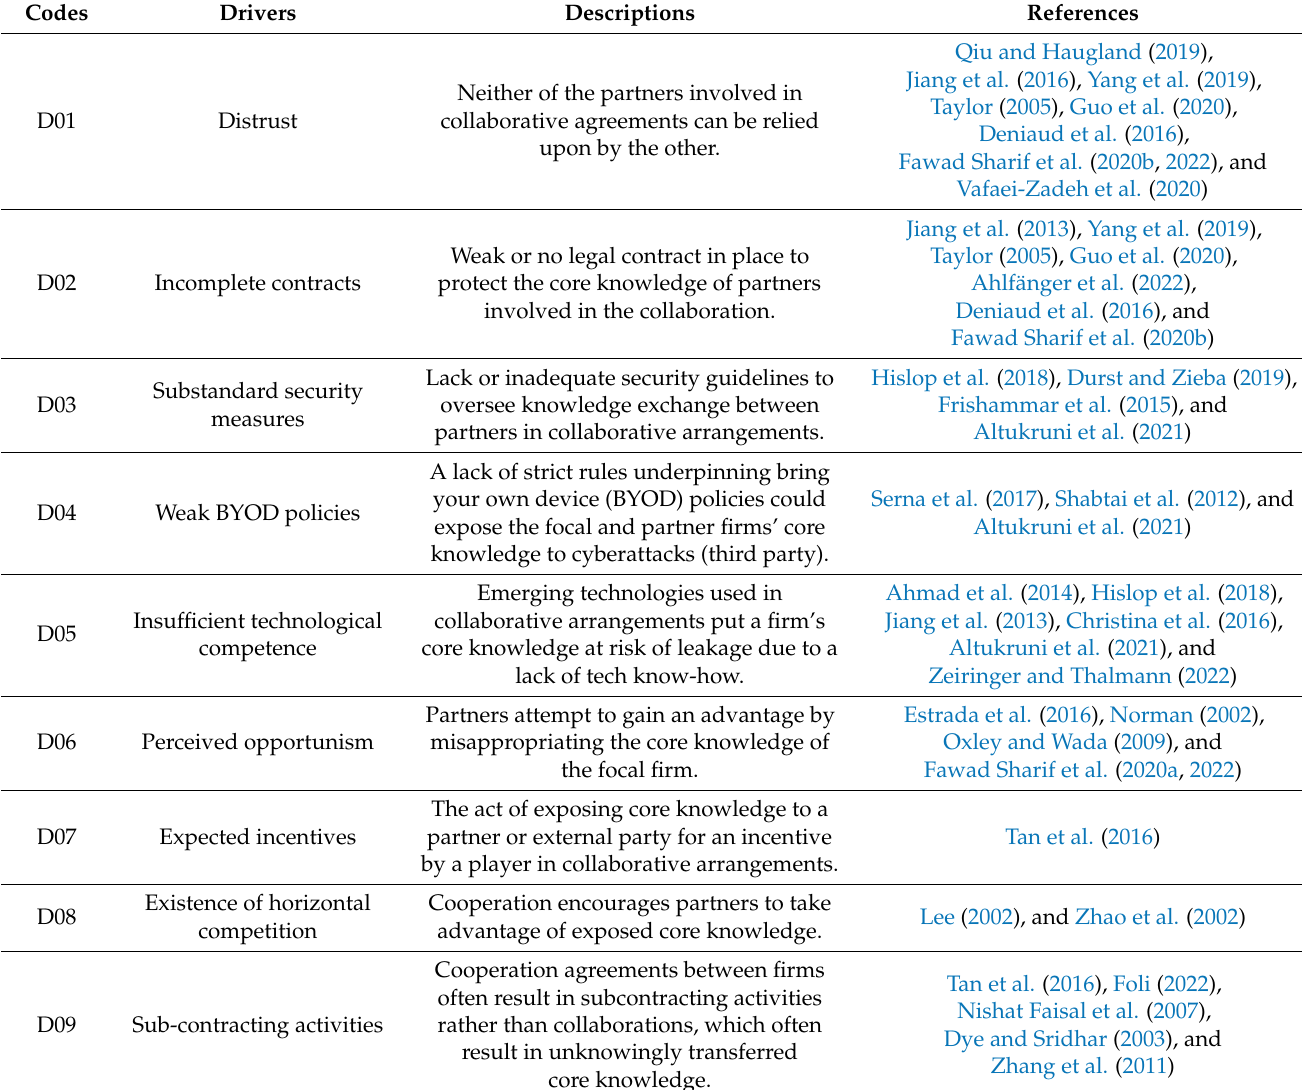
Table 1. Literature support to the identified